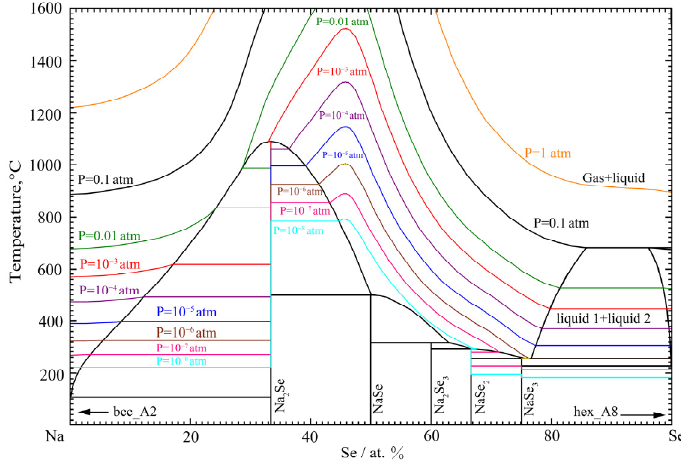
in Figure 12. In Figure 12, colored curves represent the isobars of Na-Se ideal mixed gas at different pressure. For example, the red curve represents the Na-Se ideal mixed gas isobar at the pressure of 10 − 3 atm. It can be seen that the evaporation temperature of the liquid phase decreases with the decreasing external pressure. This is similar to the Li-Se binary system in Figure 6. It also means that, as the external pressure decreases, the evaporation of the liquid phase can be significant, and even the sublimation of intermediate compounds can be expected. This high vapor pressure of the Na-Se system can easily induce difficulty in the phase diagram measurement at high temperatures. To sum up, the thermodynamic properties and phase equilibria of the Na-Se binary system were reproduced well in the present work.